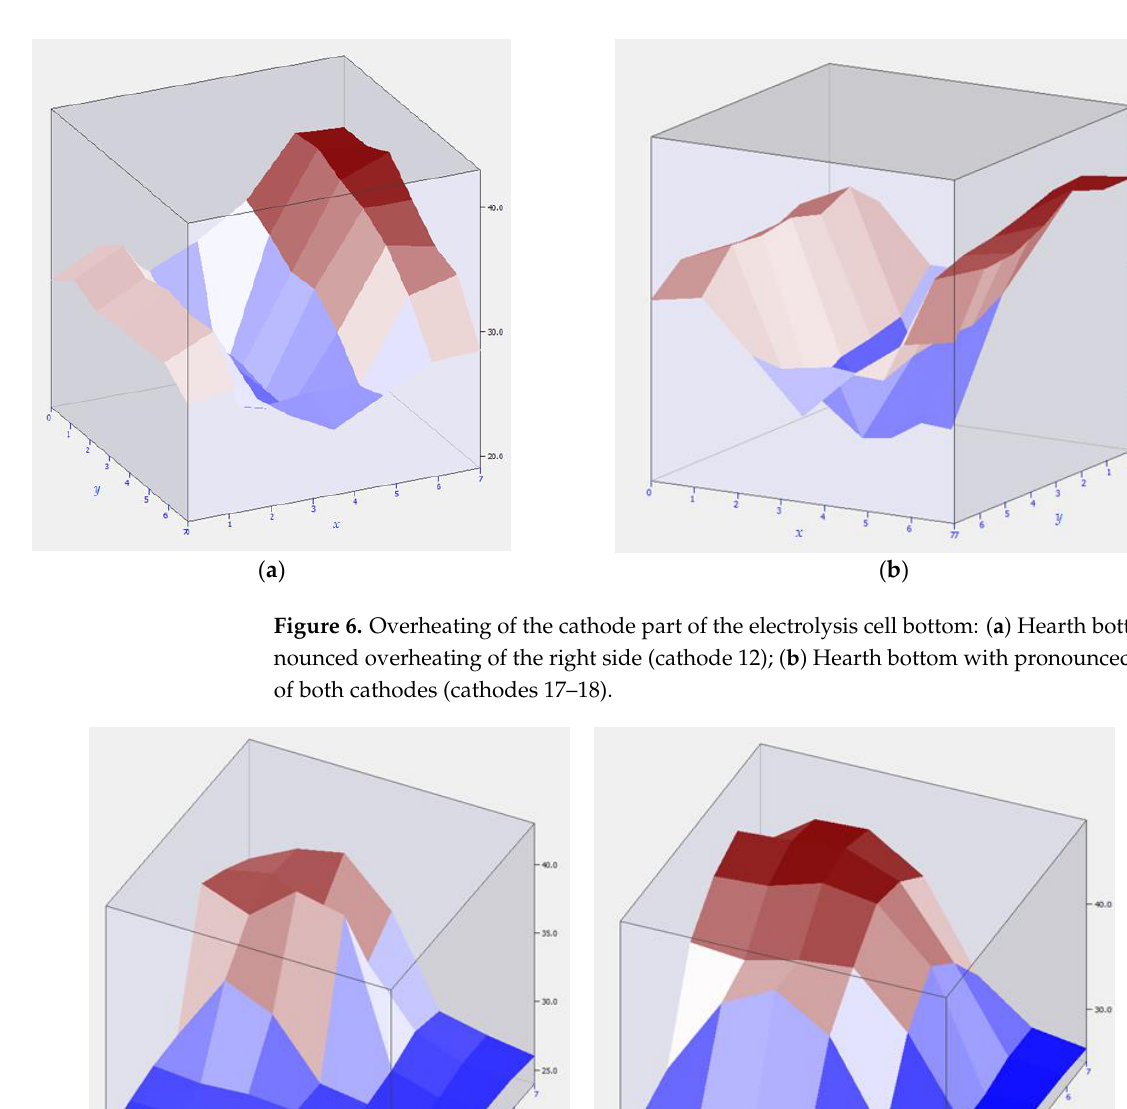
Figure 7. Overheating of the corner part of the hearth bottom at different phases of operation: ( a ) Overheating area at the initial phase of aluminum production; ( b ) Overheating area at the final phase of aluminum production.